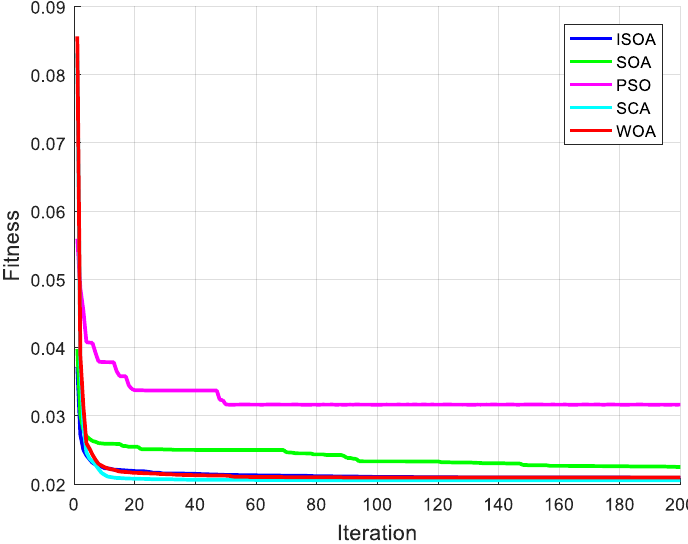
Figure 6. Fitness convergence curves of five algorithms in Experiment 1. Table 9. The predicted value of the monthly average AQI index of Taiyuan in 10 months